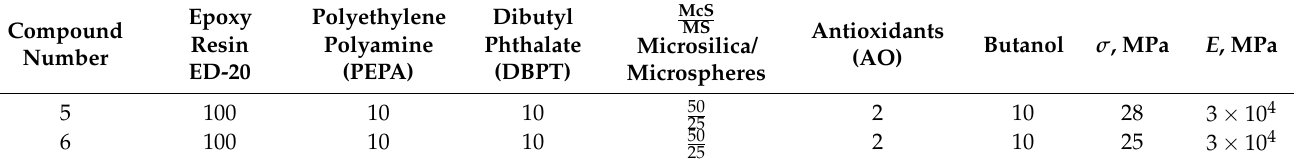
Table 7. Test compositions (by weight, %) of epoxy